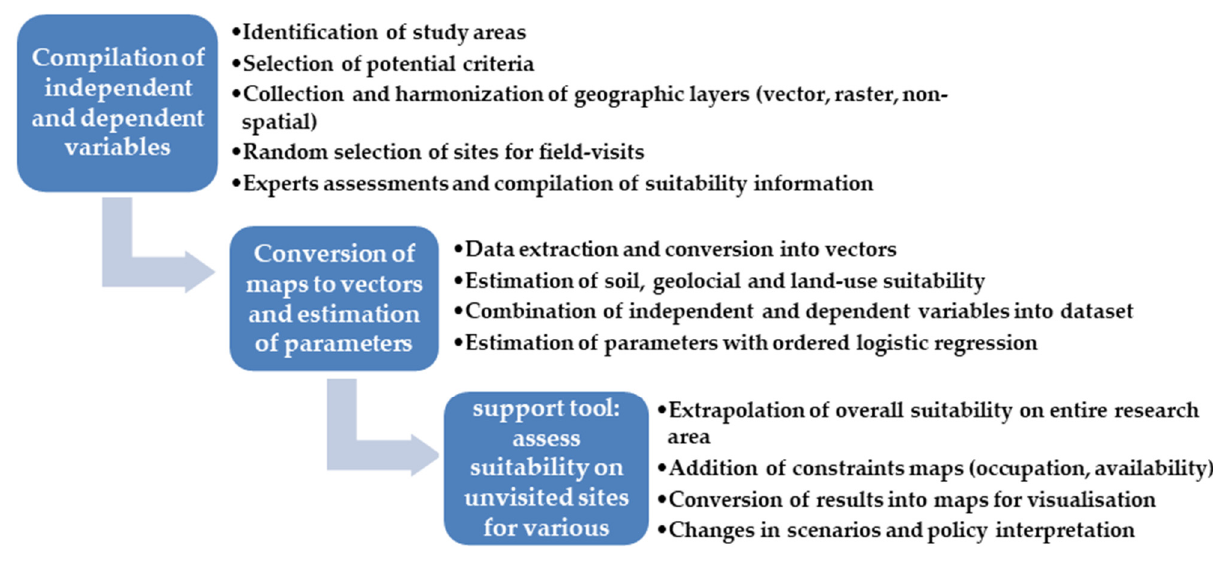
Figure 1. Methodological steps of the